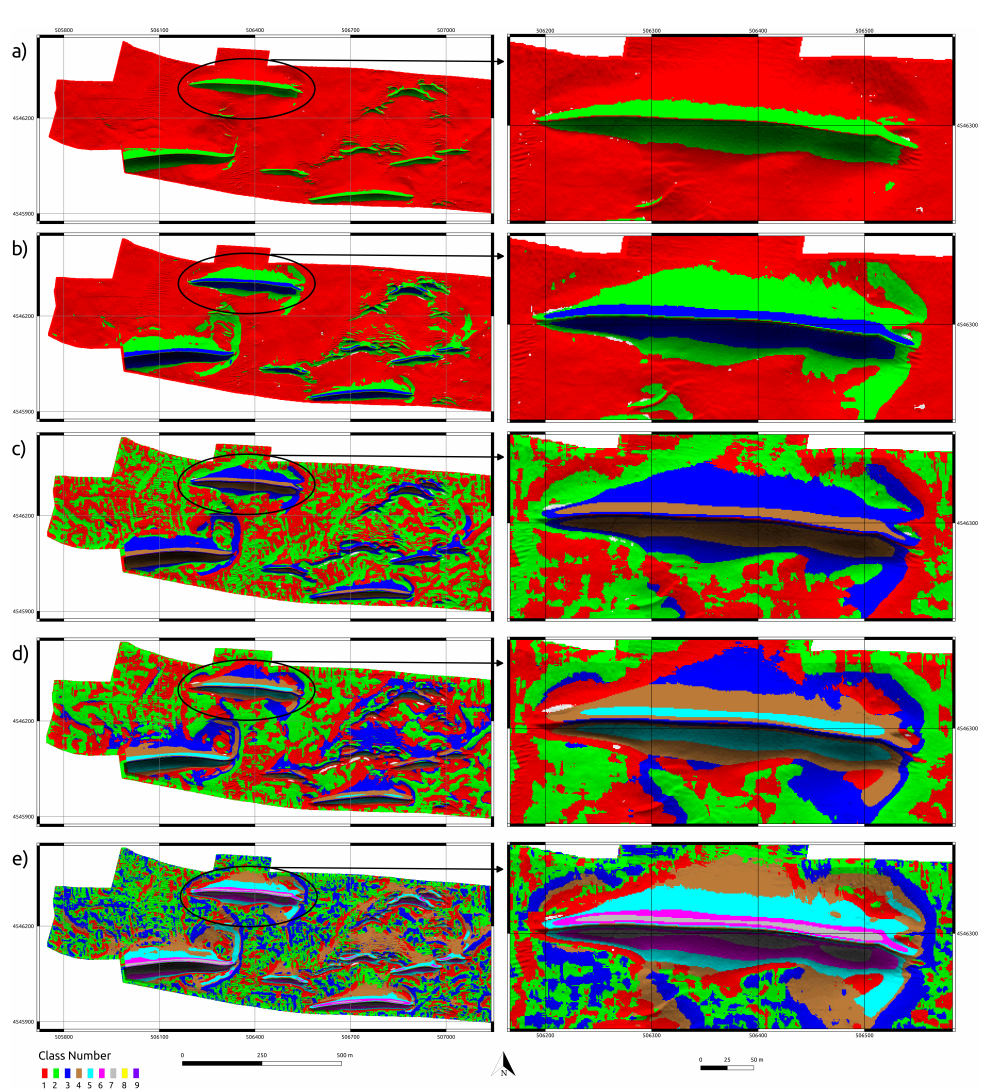
Figure 28. Output details for Model B : ( a ) three classes, window operator 5 × 5 cells; ( b ) five classes, window operator 9 × 9 cells; ( c ) five classes, window operator 15 × 15 cells; ( d ) seven classes, window operator 21 × 21 cells; and ( e ) nine classes, window operator 15 × 15 cells. The other parameter are kept constant: slope tolerance ( st = 1), curvature tolerance ( ct = 0.003), and vertical scale factor ( zs = 1). Each color represent a different class. The zoomed area on the right of each panel refer to the bedform labeled “1" in Figure